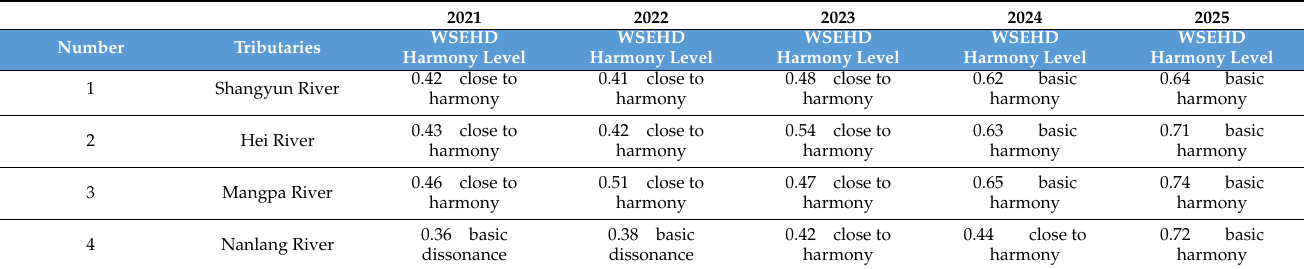
Table 3. Current year and planning year WSEHD calculation results and harmony